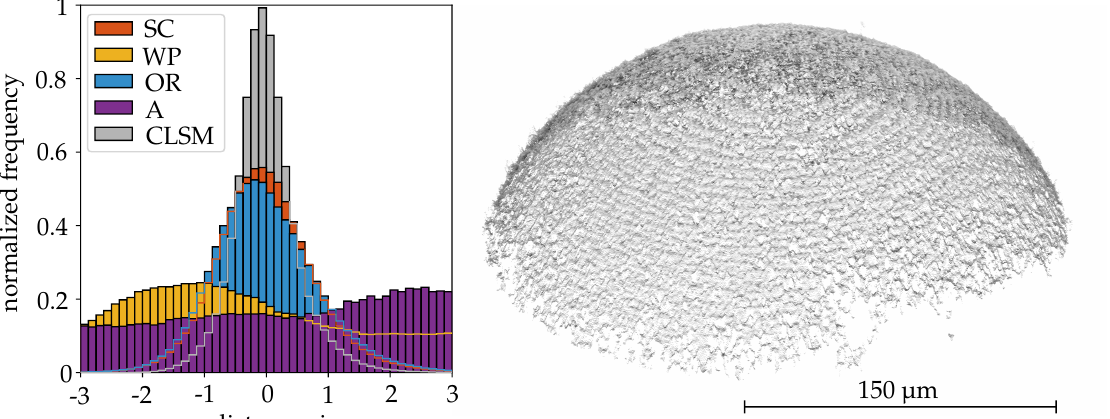
Figure 11. (left) Deviations of the reconstructed point clouds to a LSQ -sphere fit given in histogram form. For all results, a triangulation angle of ∆ ϕ Y = 10 ◦ was used. (right) Reconstructed point cloud of 1071344 points using the scaled orthographic factorization method. Table 2. Recovered parameters for a four image sequence of the 300 µm sphere. r LSQ denotes the radius of the spherical LSQ fit to the measurement result of the applied method based on 72 feature matches.